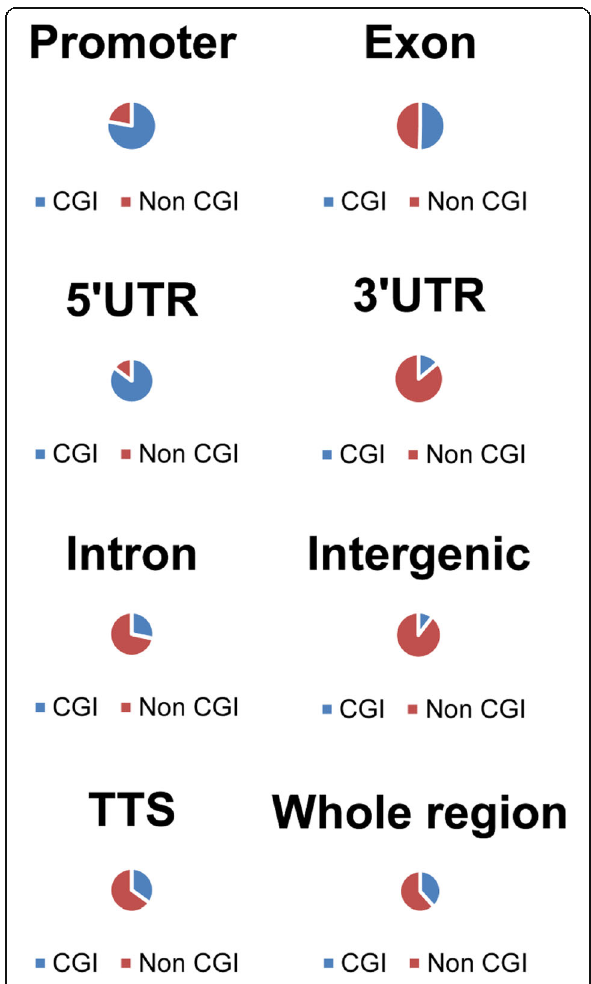
Fig. 3 Ratio of each region according to CpG islands (CGI) and